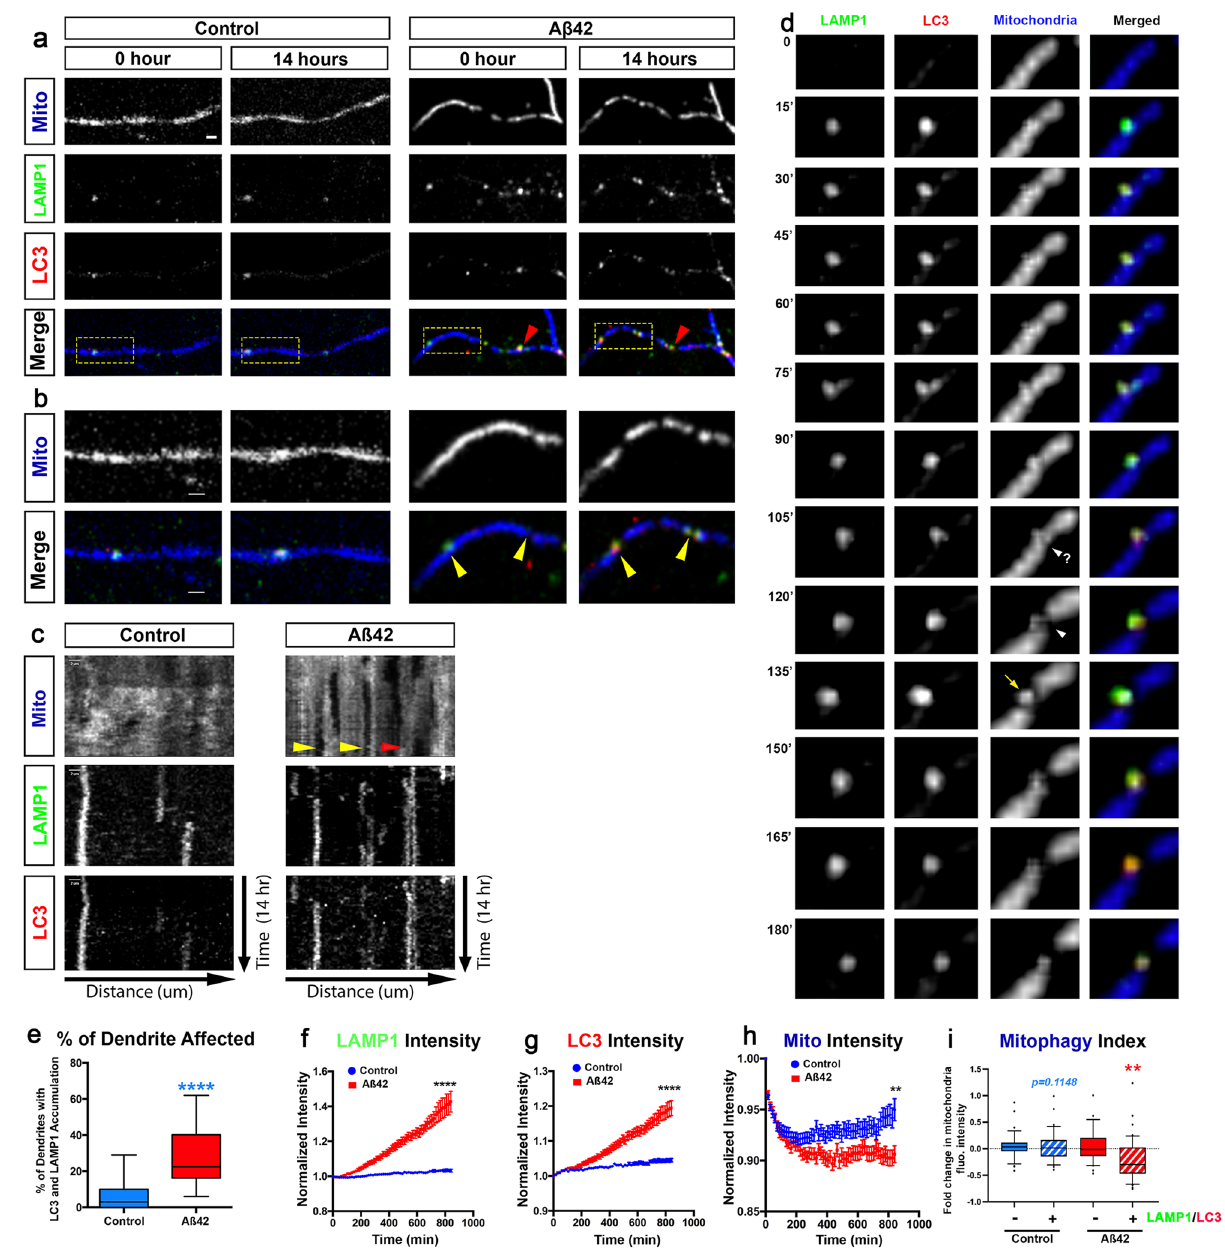
Fig. 3 | A β 42o treatment induces local mitophagy in dendrites. a , b Secondary dendritic segments from primary cortical PNs at 21 – 25 DIV, exutero electroporated at E15.5with pCAG-mito-mTagBFP2, pCAG-LAMP1-mEmerald, and pCAG-RFP-LC3to visualizemitochondria,lysosomes,andautophagosomes,respectively( a ).At21DIV, neurons were treated with either a vehicle control or A β 42o and imaged live using time-lapse microscopy every 15min for 14h. The yellow boxes label the magni fi ed areas shown in b illustrating that, in control-treated neurons, there is no signi fi cant change in LAMP1+(lysosomes), LC3+(autophagosomes), or LC3-LAMP1 double- positive(autolysosomes)vesicledynamicsand/oraccumulation(seeSupplementary Movies S1 and S2). In contrast, in dendrites of A β 42o-treated cortical PNs, sites of LAMP1-LC3 double-positive autolysosome accumulation often result in loss of mitochondriaasindicatedbyyellowarrowsinpanel b . c Representativekymographs of mitochondria, lysosomes, and autophagosomes from dendrites in panel a . The yellow arrows point to loss of mitochondrial fl uorescent signal, deemed mitophagy events. The red arrow indicates no decrease in mitochondrial signal, despite LAMP1 and LC3 signal, indicating an incomplete mitophagy event. d Detail of an